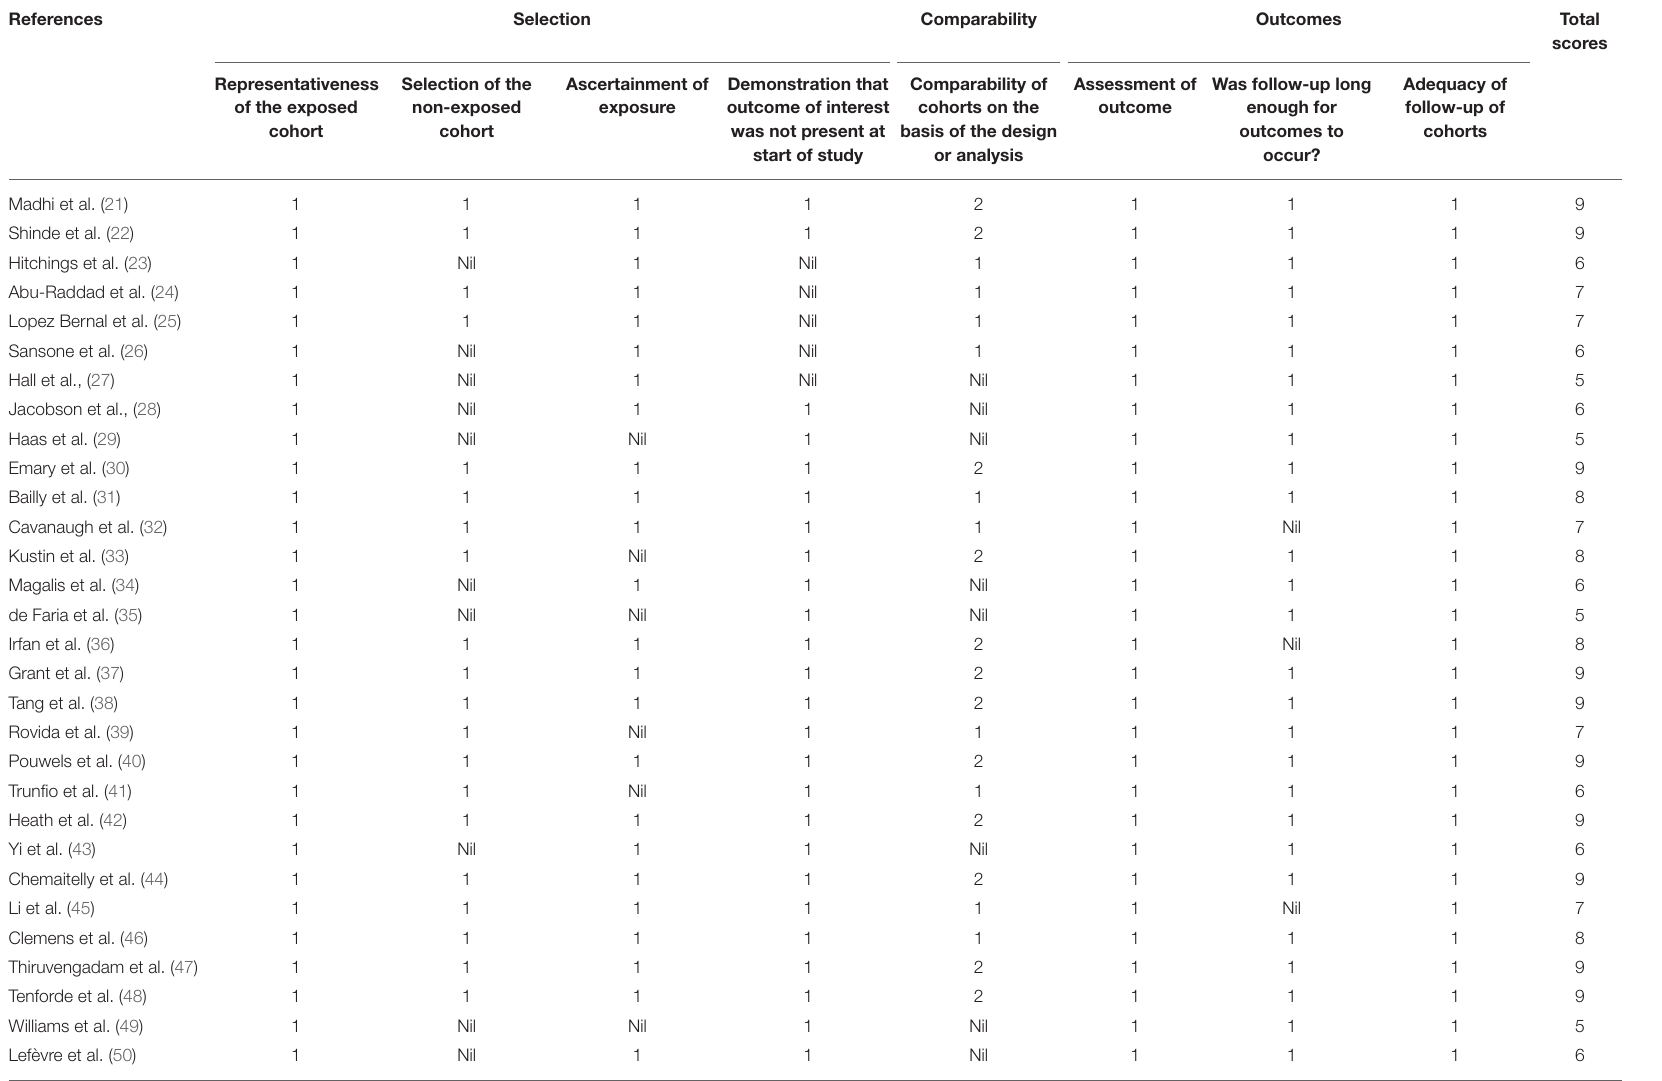
TABLE 1 | Quality evaluation of eligible studies based on the Newcastle-Ottawa